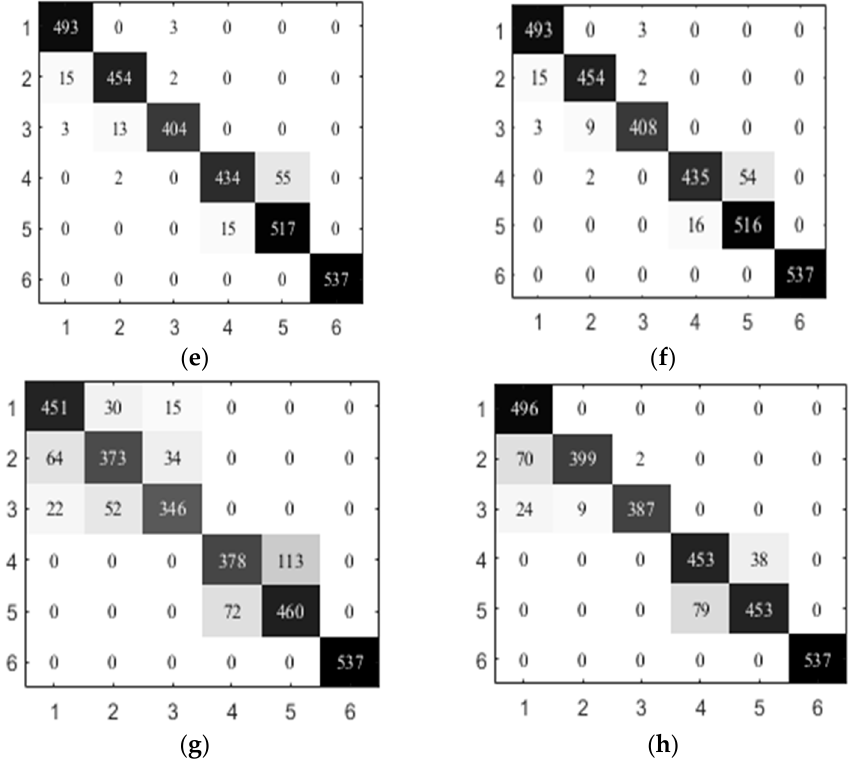
Figure 4. Comparison of the confusion matrix on UCI-HAR. ( a ) NB; ( b ) NB-SVM; ( c ) KNN; ( d ) KNN-SVM; ( e ) SVM; ( f ) SVM-SVM; ( g ) DT; ( h ) DT-SVM.